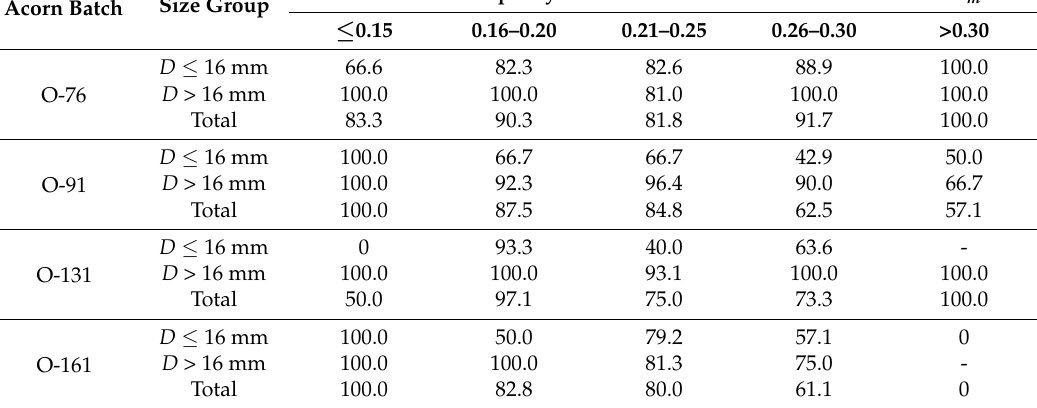
Germination capacity of acorns from different size groups relative to their mass scarification